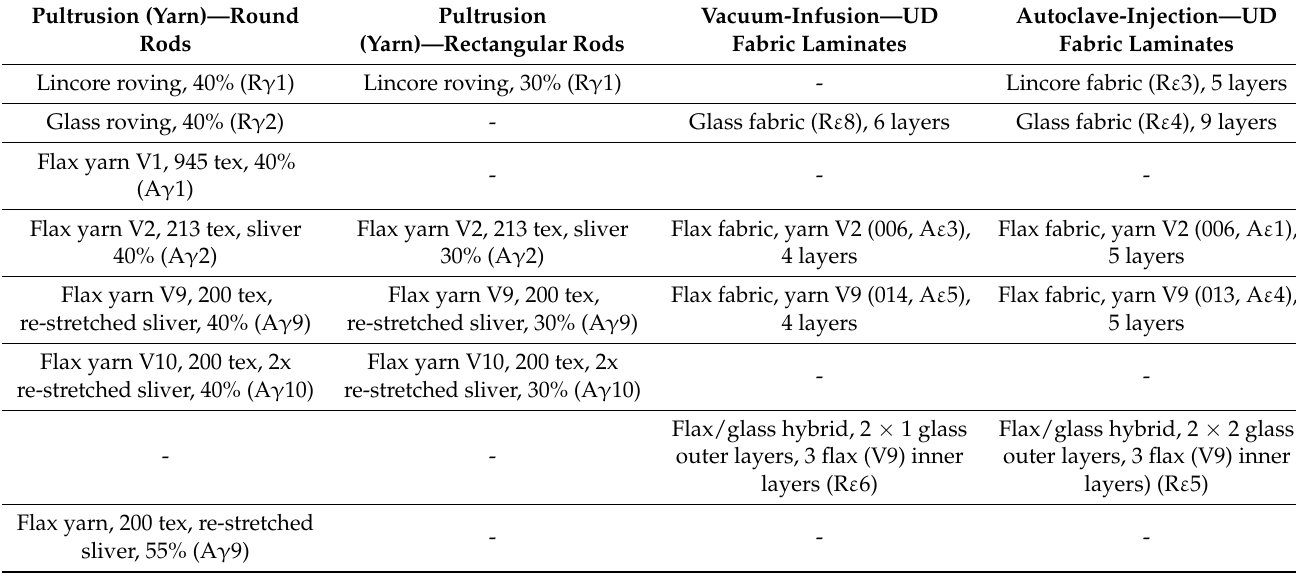
Table 2. Selected composites produced by different manufacturing processes from rovings, yarns and fabrics (designations in brackets with Greek letters indicate internal labels used for the classification of the samples in the project).